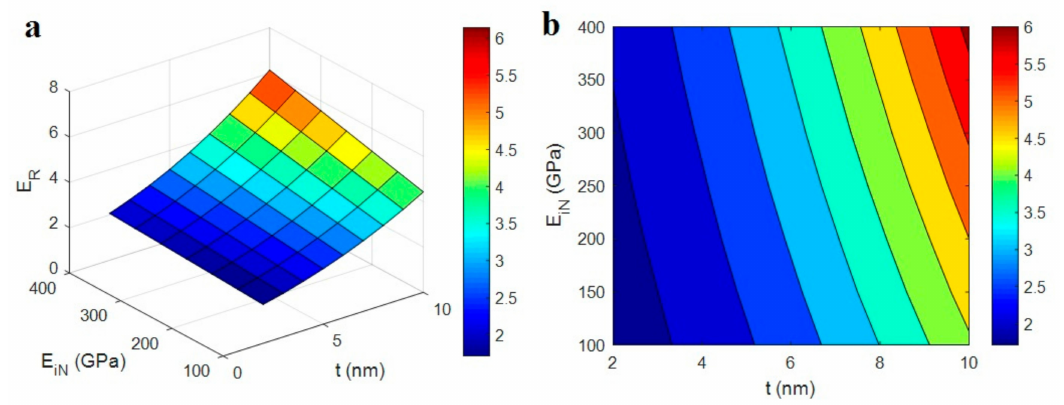
Figure 5. The roles of “ t ” and “ E iN ” parameters in the relative modulus according to Equation (11): ( a ) 3D and ( b ) contour